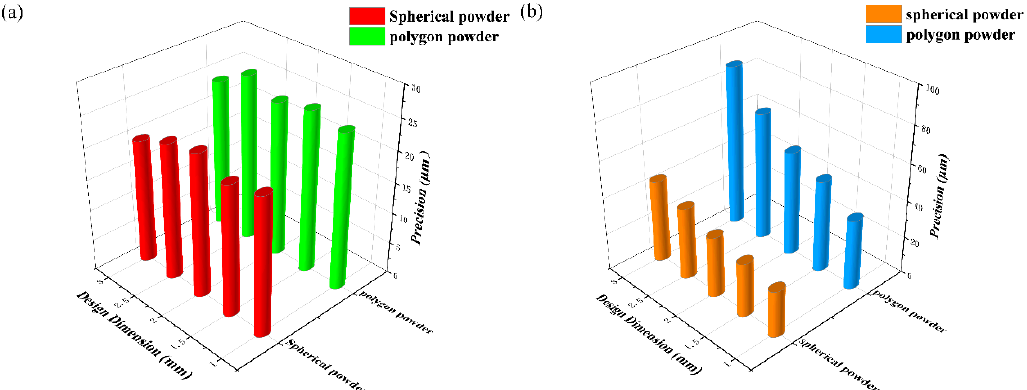
Figure 3. Absolute precision of Mo sample formed by SLM: ( a ) xy-plane direction, ( b ) z-direction.